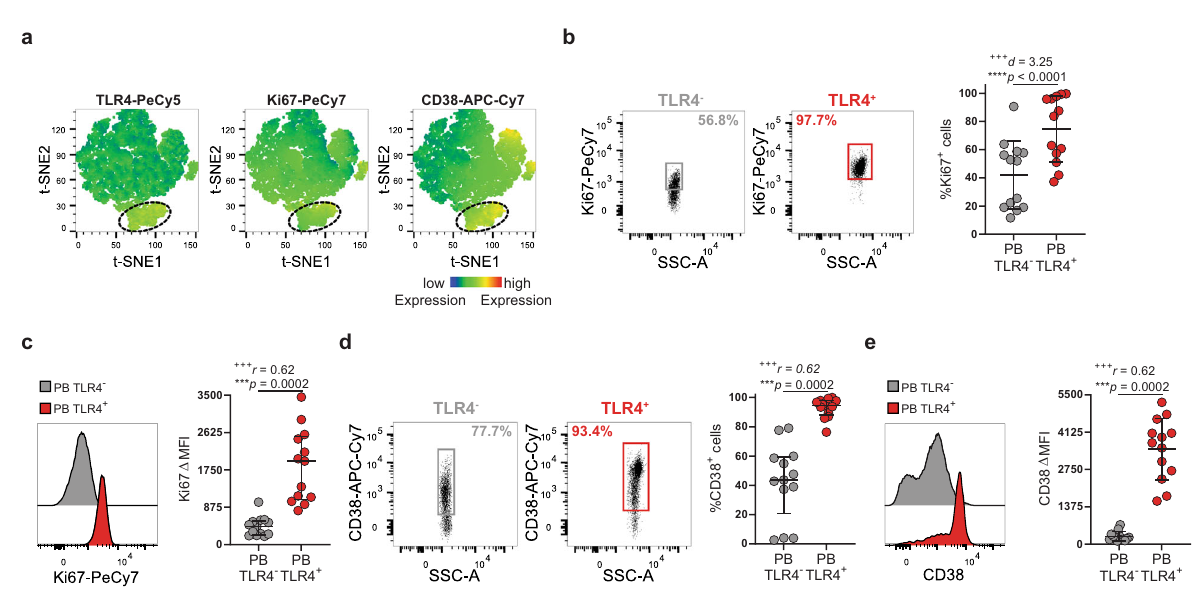
Fig. 2 TLR4 + T cells display an activated and proliferative phenotype. a t-SNE plots of peripheral blood total CD3 + CD4 + T cells. The color indicates cell expression levels of labeled markers (TLR4, Ki-67, and CD38). Circle demarks TLR4 + cells ( n = 6 RA patients). b , c Representative dot plots and cumulative graphs of the b frequency and c Δ MFI of Ki-67 expression by TLR4 − and TLR4 + peripheral blood T cells ( n = 13 RA patients). d , e Representative dot plots and cumulative graphs of the d frequency and e Δ MFI of CD38 expression by TLR4 − and TLR4 + peripheral blood T cells ( n = 13 RA patients). Δ MFI was calculated to correct for the distinct auto fl uorescence of the TLR4 − and TLR4 + T-cell populations. Δ MFI was calculated by subtracting the fl uorescence intensity minus one (FMO) from median fl uorescence intensity (MFI) for each given marker. Data are presented as mean ± SD, for parametric statistical tests, or median ± IQR, for non-parametric statistical tests. Sample normality distribution was tested by using D ’ Agostino & Pearson normality test. P values **** p ≤ 0.0001, *** p ≤ 0.001, ** p ≤ 0.01, * p ≤ 0.05 were determined by ( b ) Paired t test and ( c – e ) Wilcoxon matched-pairs rank test. Effect size measures +++ high, ++ medium, + small were determined by ( b ) d – Cohen ’ s d and ( c – e ) r – correlation coef fi cient r